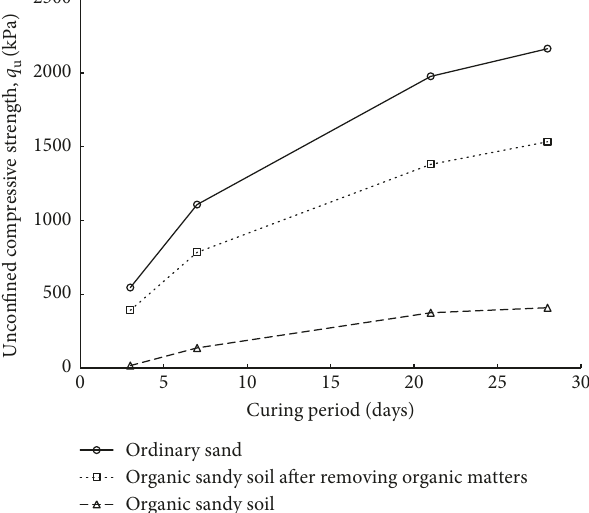
Figure 15: Unconfined compression test for cement-admixed sand.